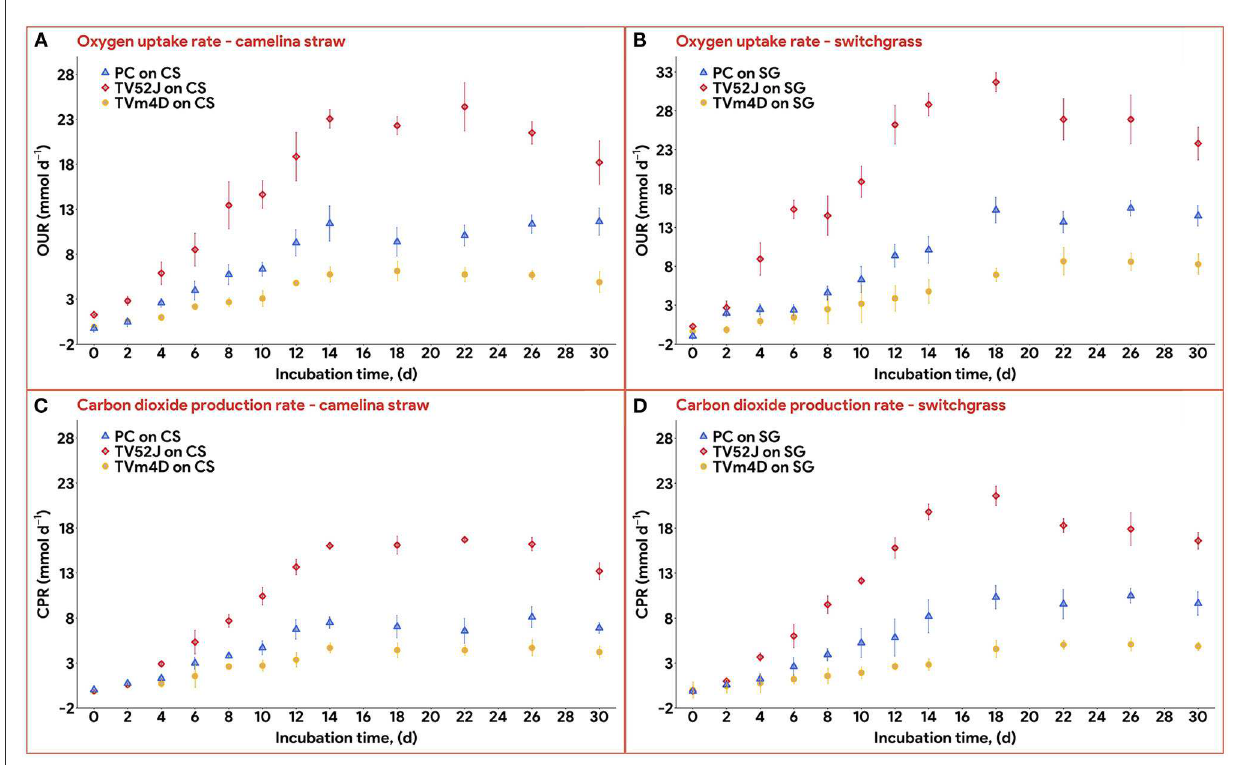
FIGURE5 Oxygen uptake rate and carbon dioxide production rate: (A) : OUR profiles of the three fungi on CS, (B) : OUR profiles of the three fungi on SG, (C) : CPR profiles of the three fungi on CS, (D) : CPR profile of the three fungi on SG. OUR, oxygen uptake rate; CPR, carbon dioxide production rate; PC, P. chrysosporium ; TV52J, T. versicolor 52J; TVm4D, T. versicolor m4D; CS, camelina straw; SG,